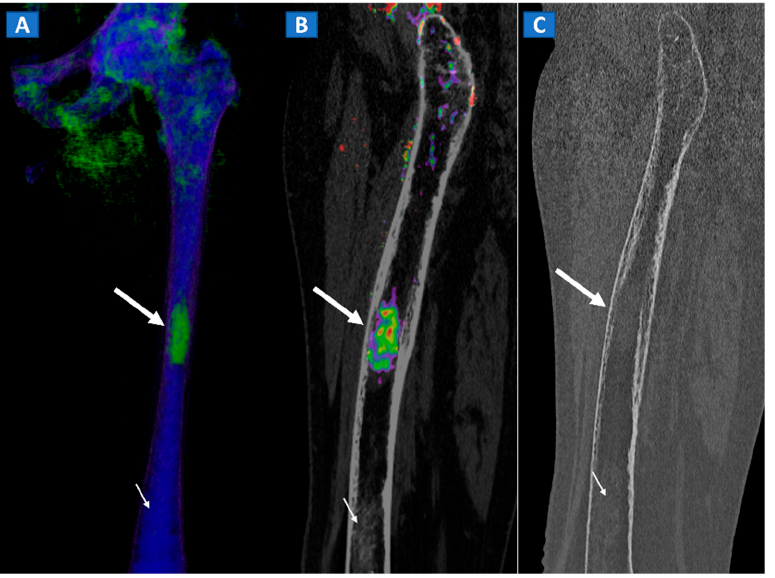
Figure 11. A 49-year-old female with single occult femoral metastasis from breast cancer. On the 3D DECT image ( A ) a focal area of edema can be clearly recognized on the left femur (thick arrow). On the para-sagittal 2D image, the lesion (thick arrow) is confirmed on the super-imposed BME map ( B ). The lesion (thick arrow) is not recognized on the para-sagittal 2D bone window image ( C ), showing only a non-specific mildly hyperdense pattern, present also on distal femur (thin arrow), and not associated with BME on the DECT images.